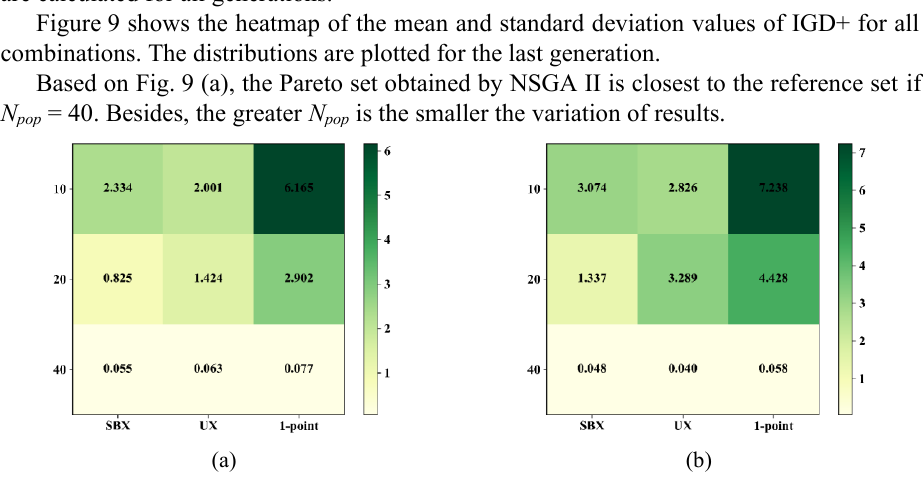
Fig. 9 . Heatmap of mean (a) and standard deviation (b) values of IGD+ for the last generation of the algorithm.